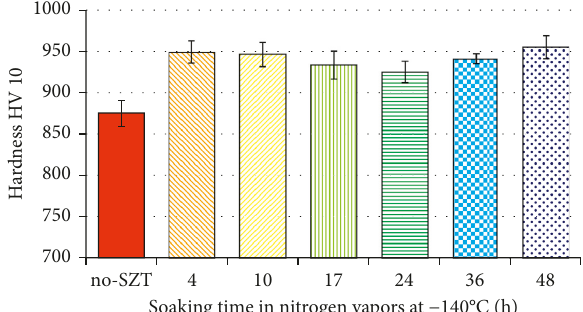
Figure 7: Bulk hardness HV 10 of the Vanadis 6 after SZT with different soaking times in nitrogen vapors.